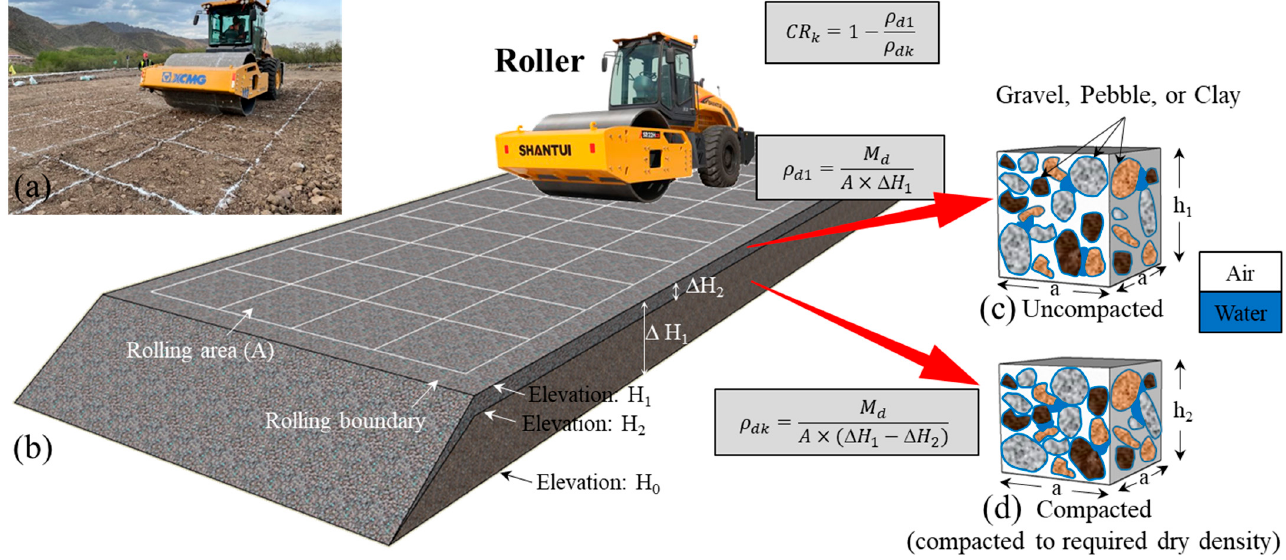
Figure 2. Compaction model of filling material: ( a ) Photo of the compaction site; ( b ) Simplified model of compacted material; ( c ) Simplified model of uncompacted material; and ( d ) Compaction model of embankment dam.